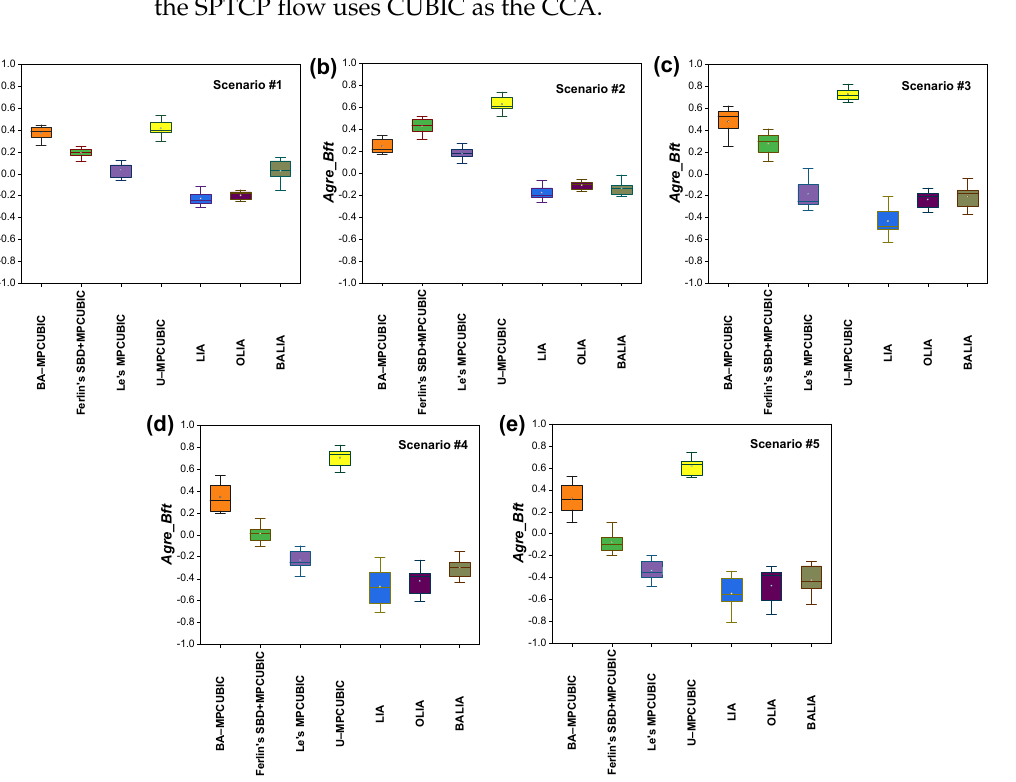
Figure 7. Performance comparison in terms of Agre _ Bft for the considered MPTCP CCAs. ( a – e ) Agre _ Bft for Scenarios #1–5.